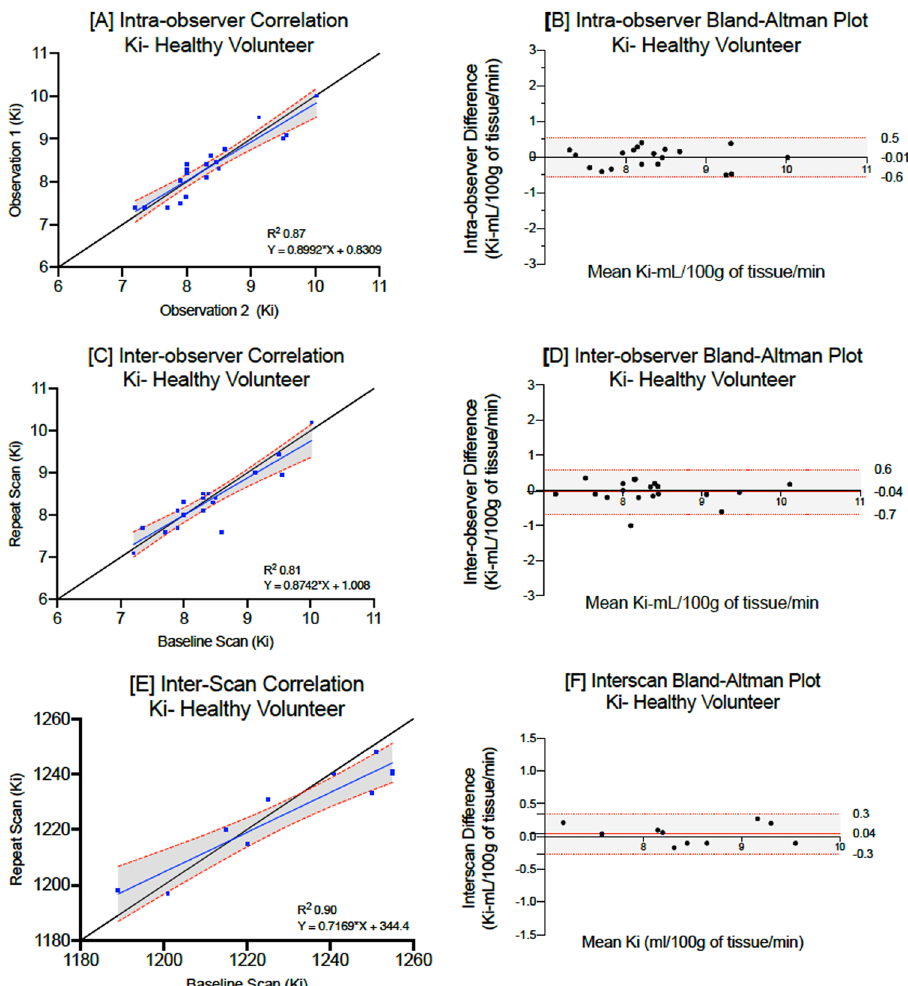
Figure 2. Intra, inter- observer repeatability and scan–rescan reproducibility for myocardial manganese uptake in healthy volunteers. Linear regression analysis and Bland–Altman plots demonstrating